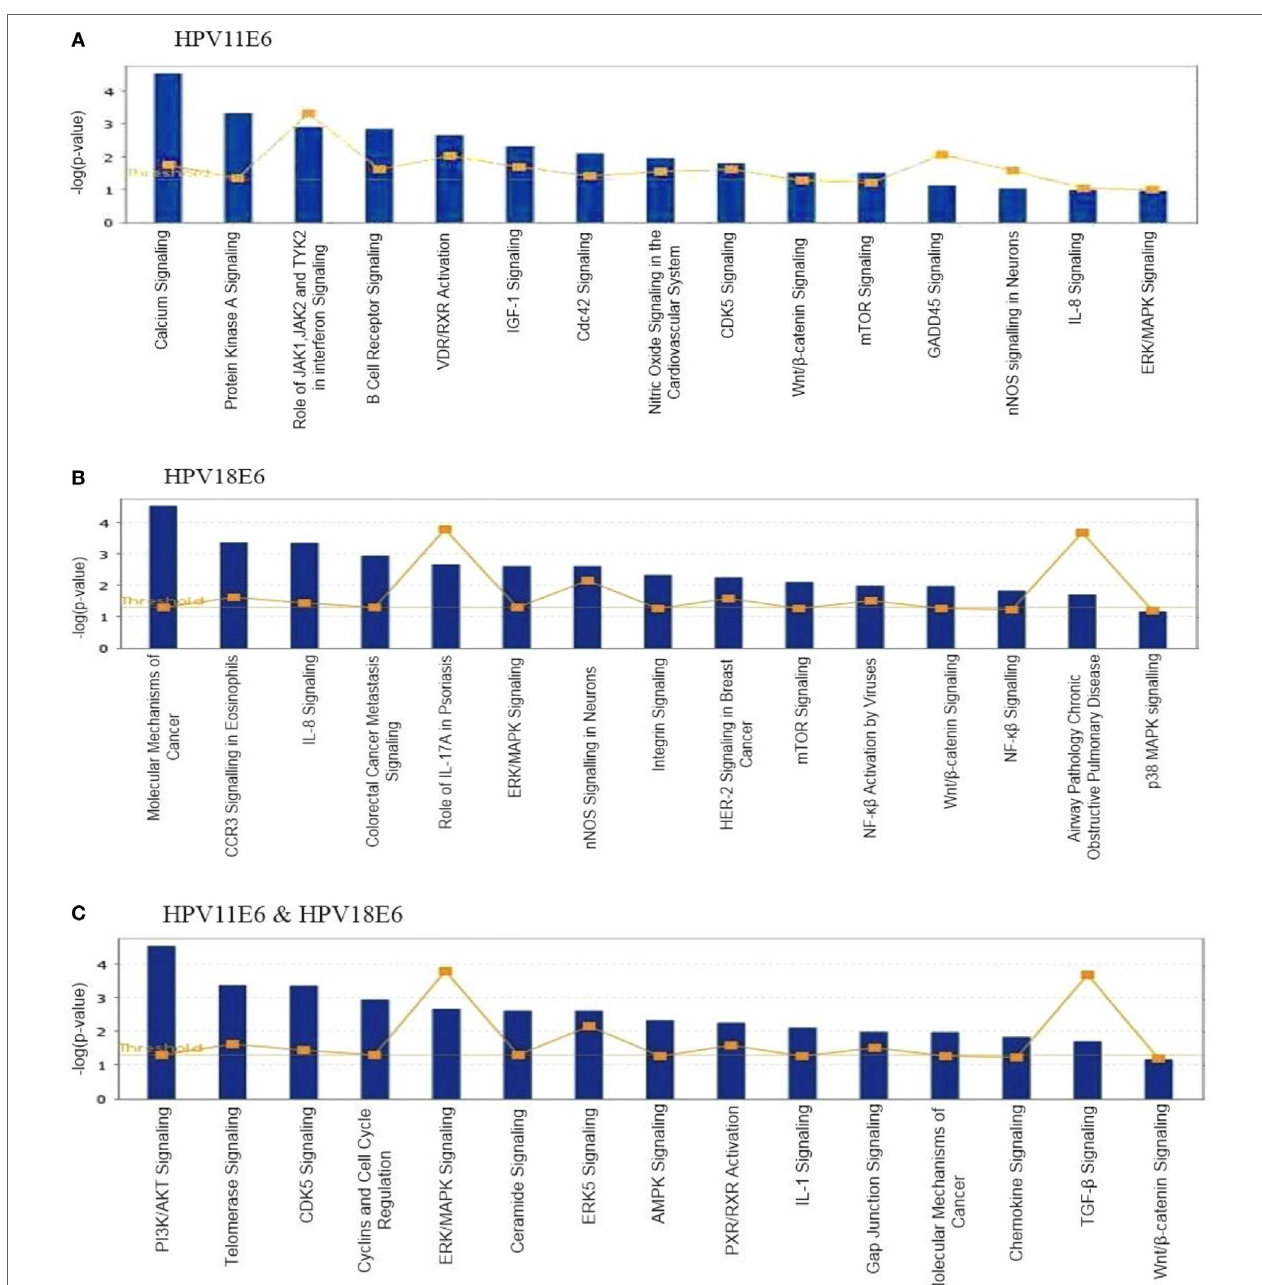
FigUre 6 | Ingenuity ™ pathway analysis (IPA) canonical pathway analysis. Top pathways in which significant differentially expressed genes (DEGs) were enriched, following the expression of (a) HPV11E6; (B) HPV18E6; (c) HPV11E6, and HPV18E6 in HaCaT cells. Calcium signaling was the top significantly enriched pathway induced by HPV11E6 while HPV18E6 induced the molecular mechanisms of cancer as the top deregulated canonical pathway. The DEGs shared by both HPV11E6 and HPV18E6 induced PI3K/AKT signaling and telomerase signaling as the top most deregulated pathways. Bars represent -log ( p -value) for disproportionate representation of affected genes in the selected pathway, the yellow boxed line represents the ratio of affected genes to the total number of genes in a